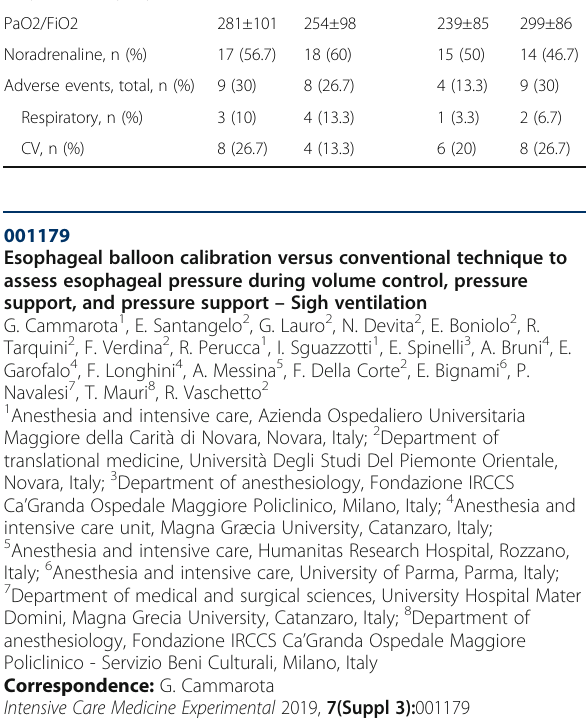
Table 1 (abstract 001175). Comparison of end points without mortal patients